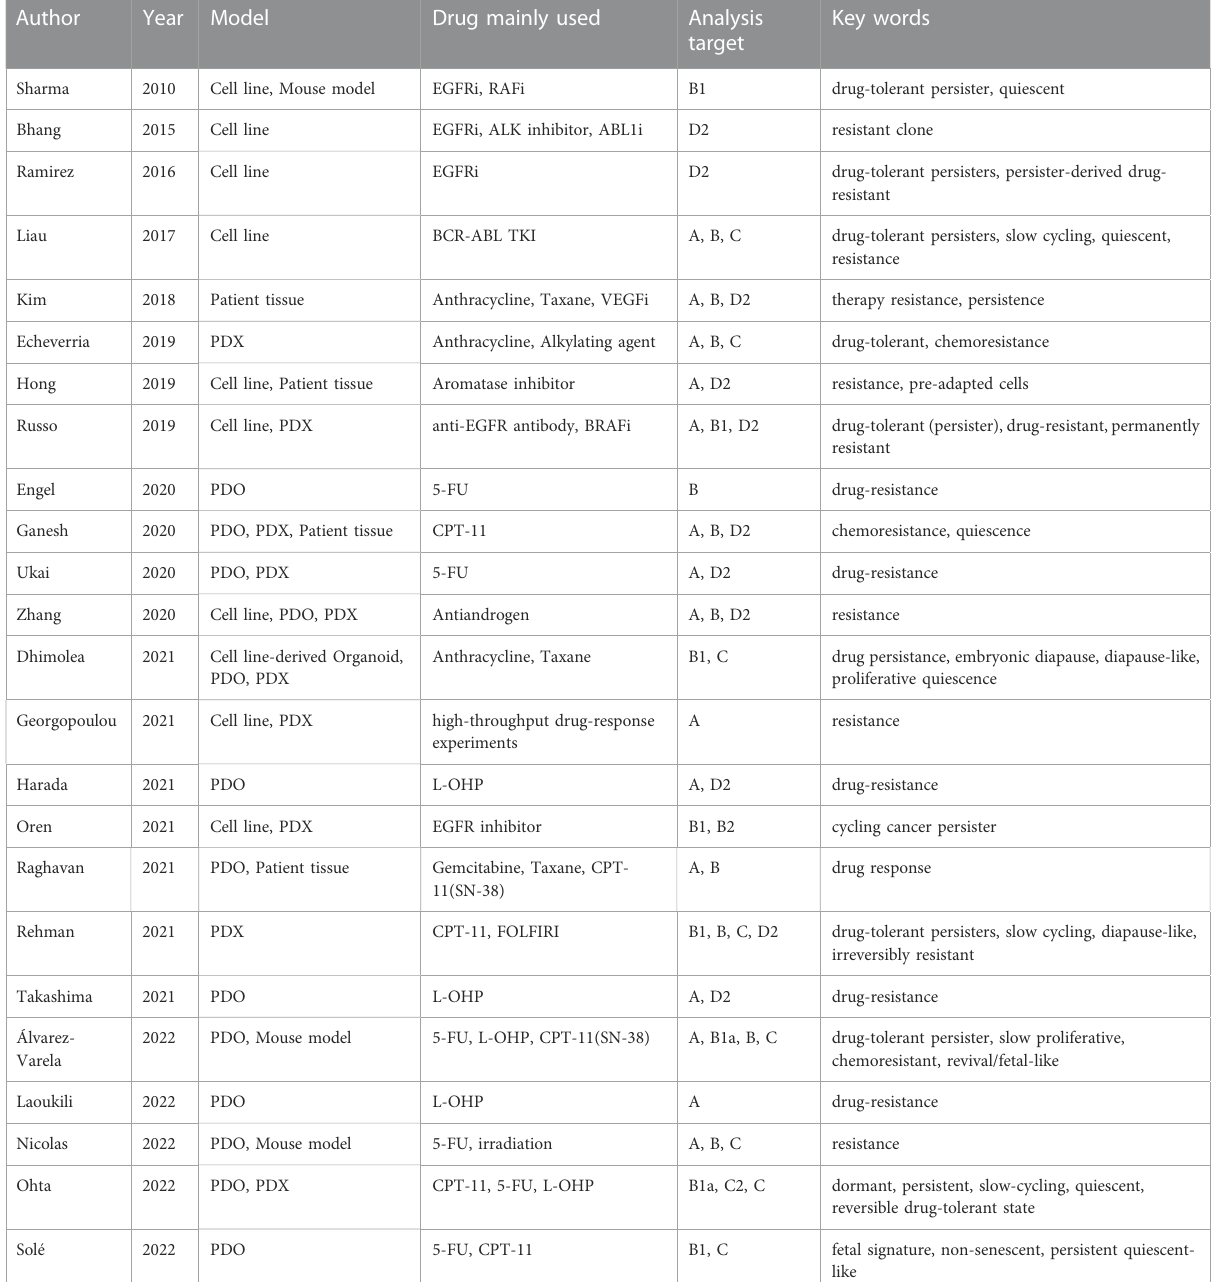
TABLE 1 Classi fi cation of analysis targets in publications on treatment-survived or regrown cells.